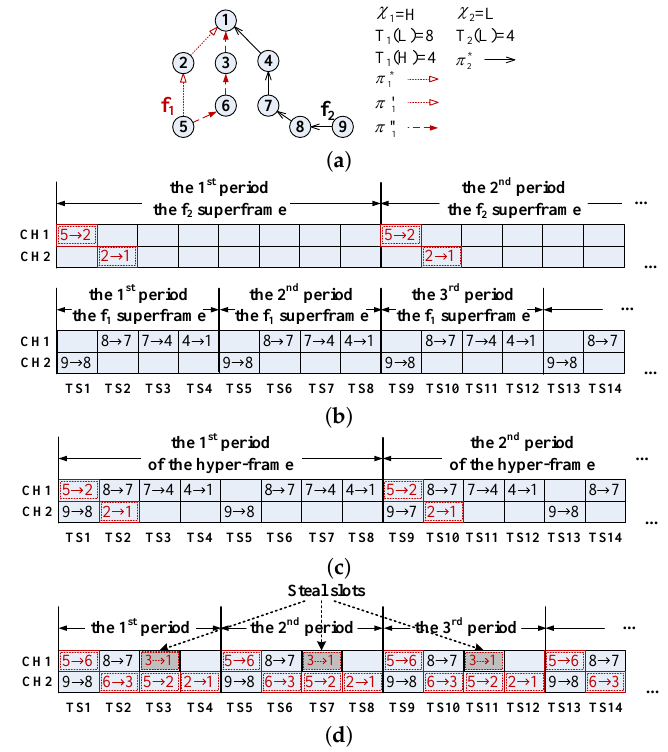
Figure 2. Graph routing and superframe. ( a ) A network; ( b ) superframes with different periods; ( c ) a hyper-frame; ( d ) the flow f 2 steal slots from the flow f 1